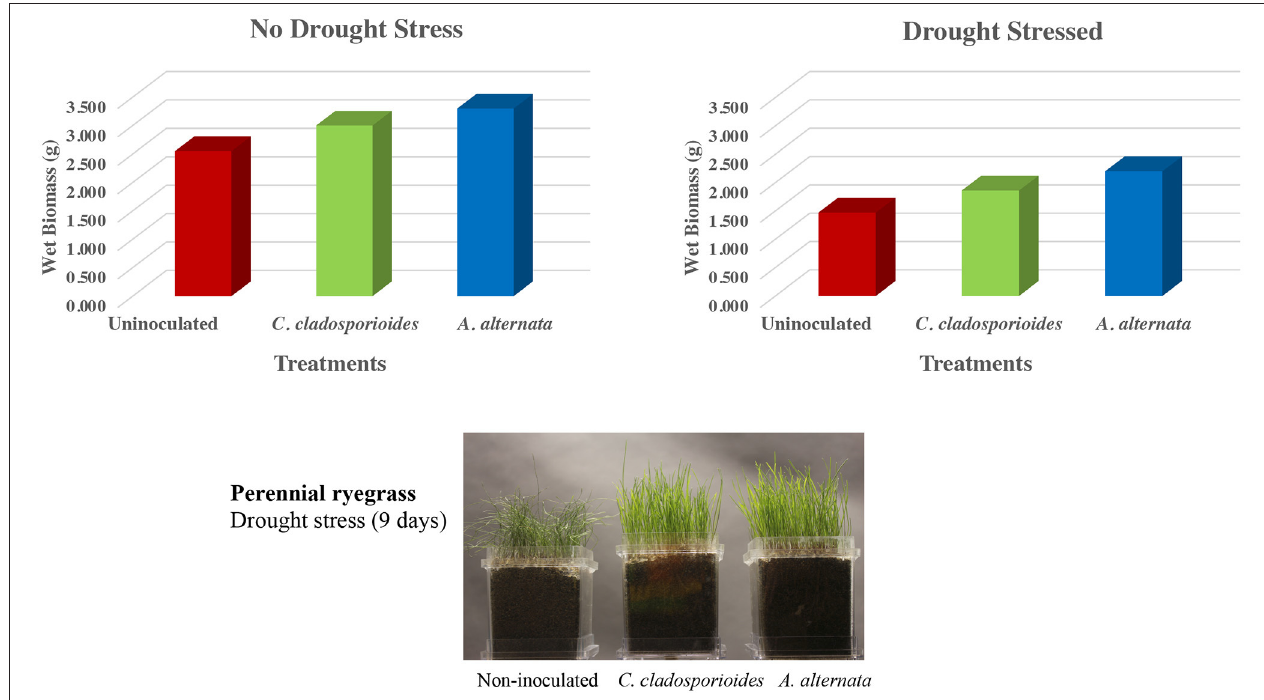
FIGURE 3 | Drought stress studies in double-decker magenta boxes containing uninoculated or symbiotic ( C. cladosporioides or A. alternata ) treated ryegrass seeds (545 seeds/box) grown for 12 days when fluid was removed from the lower chamber of ( N = 4 magenta boxes) to begin drought stress. Four additional magenta boxes remained as hydrated controls. After 9 days in the absence of fluids, 200 mls of fluid was added back to all the boxes and plants were allowed to recover for 7 days and the wet biomass (g) of ryegrass shoots were assessed. No significant differences in biomass were observed in the absence of stress (SD = 0.39–0.79; P = 0.209–0.394) and statistically significant differences were observed in both symbiotic plants (indicated with *; SD = 0.12–0.28; P = 0.014–0.016) when compared to uninoculated plants in the presence of drought stress. A representative photograph of ryegrass plants prior to shoot harvests after 9 days of drought stress (bottom panel). Statistical analysis was conducted with Student’s t -test to determine significance between two groups (i.e., symbiotically treated vs. uninoculated controls). Values of P < 0.05 were considered to be statistically